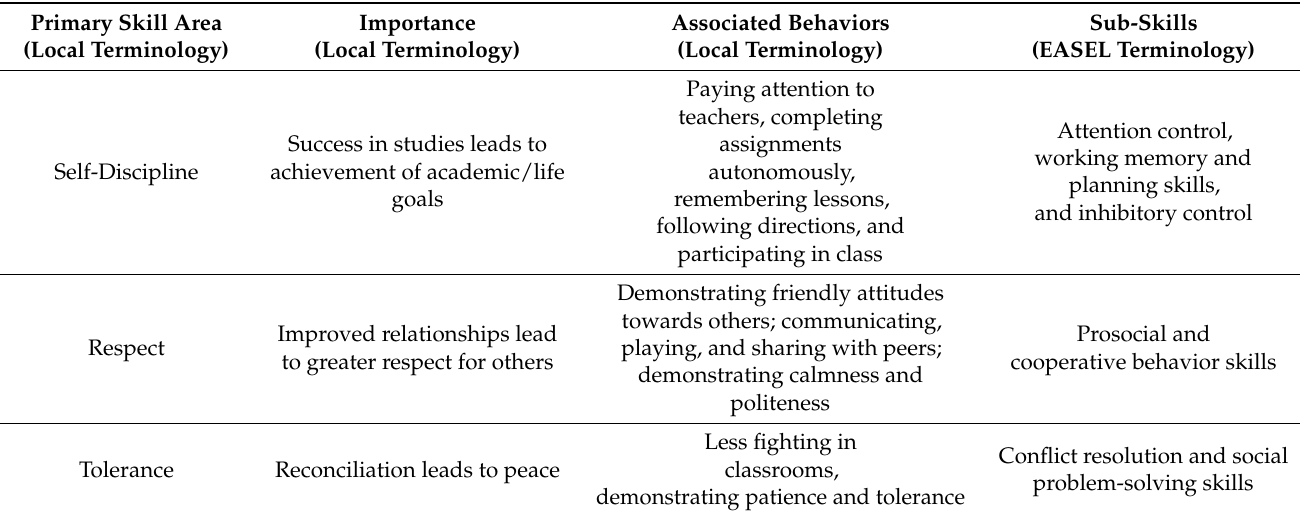
Table 1. Primary skill